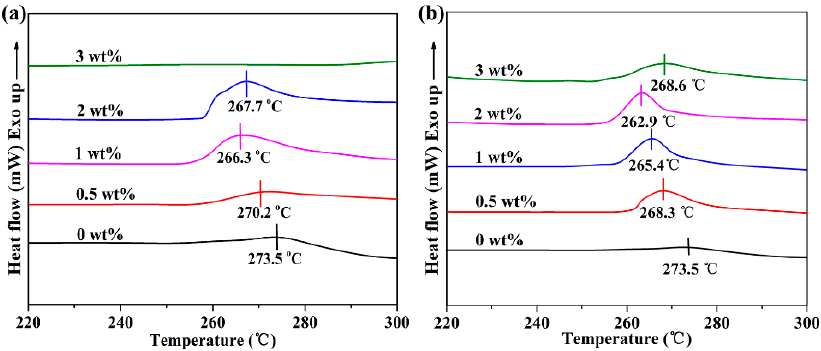
Figure4. Thee ff ectofh-BNandh-BN@(PDA + PEI)loadingonthecoldcrystallizationofnanocomposites: Figure 4. The effect of h-BN and h-BN@(PDA+PEI) loading on the cold crystallization of ( a ) h-BN / PEN nanocomposites; ( b ) h-BN@(PDA + PEI) / PEN nanocomposites at the heating rate nanocomposites: ( a ) h-BN/PEN nanocomposites; ( b ) h-BN@(PDA+PEI)/PEN nanocomposites at the heating rate of 10 °C/min, respectively.